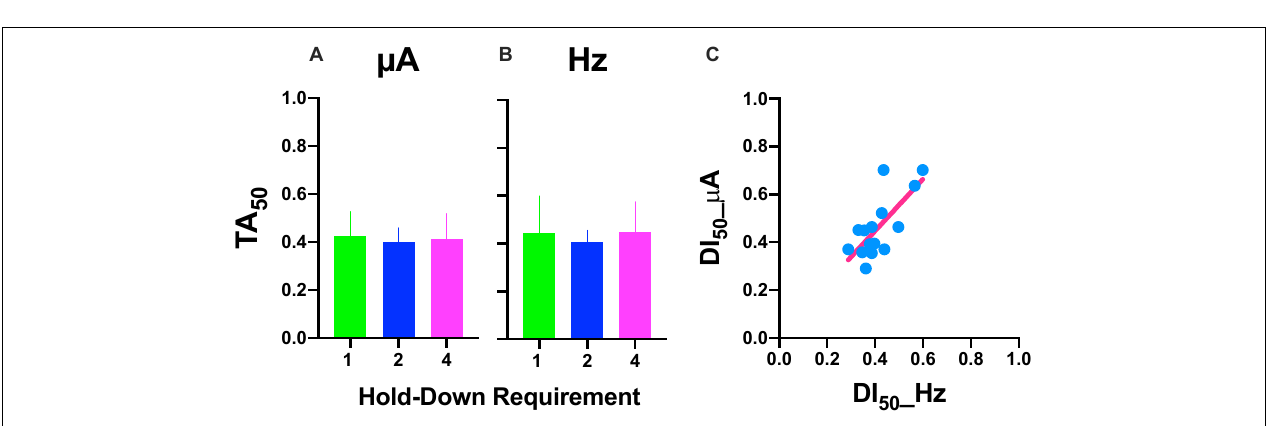
0.0 0.2 0.4 0.6 0.8